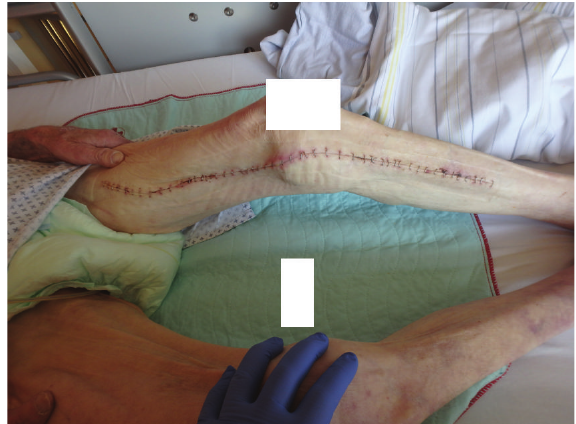
Figure 6: Left leg after operation with good healing process.